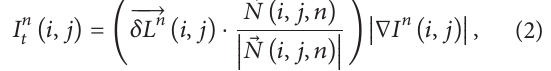
and ∇ 𝑁 𝐼 , ∇ 𝑆 𝐼 , ∇ 𝐸 𝐼 , ∇ 𝑊 𝐼 represent the difference between the intensities of the pixel in the direction indicated by the index (north, south, east, or west) and the current